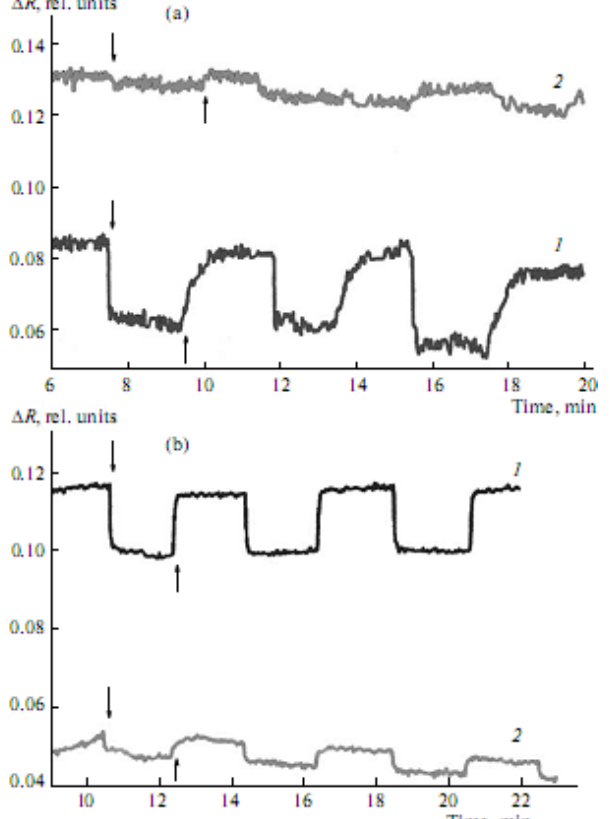
Figure 5. Reversible changes in the intensity of absorption at λ = 446 nm of type-Ib CCDs as a function of the time of exposure to light with a wavelength of 438 nm and dark relaxation of the monolayers formed on the surface of ( a ) 10 mM KCl solution at surface pressures of (1) 3 mN/m and (2) 9 mN/m, and ( b ) 10 mM NaCl solution at surface pressures of (1) 3 mN/m and (2)14mN/m (↓—indicates that the light is on; ↑—indicates that the light is